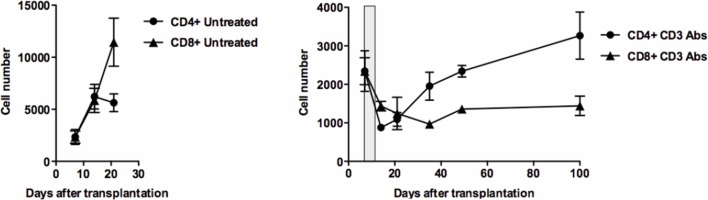
Intragraft T cell counts.Pancreatic islet allografts were recovered from untreated (left) or CD3 antibody-treated (right) mice and CD4+ and CD8+ T cells were counted at different time-points post-transplant.CD3 antibody treatment was applied on day +7 post-transplant for 5 days (gray area).